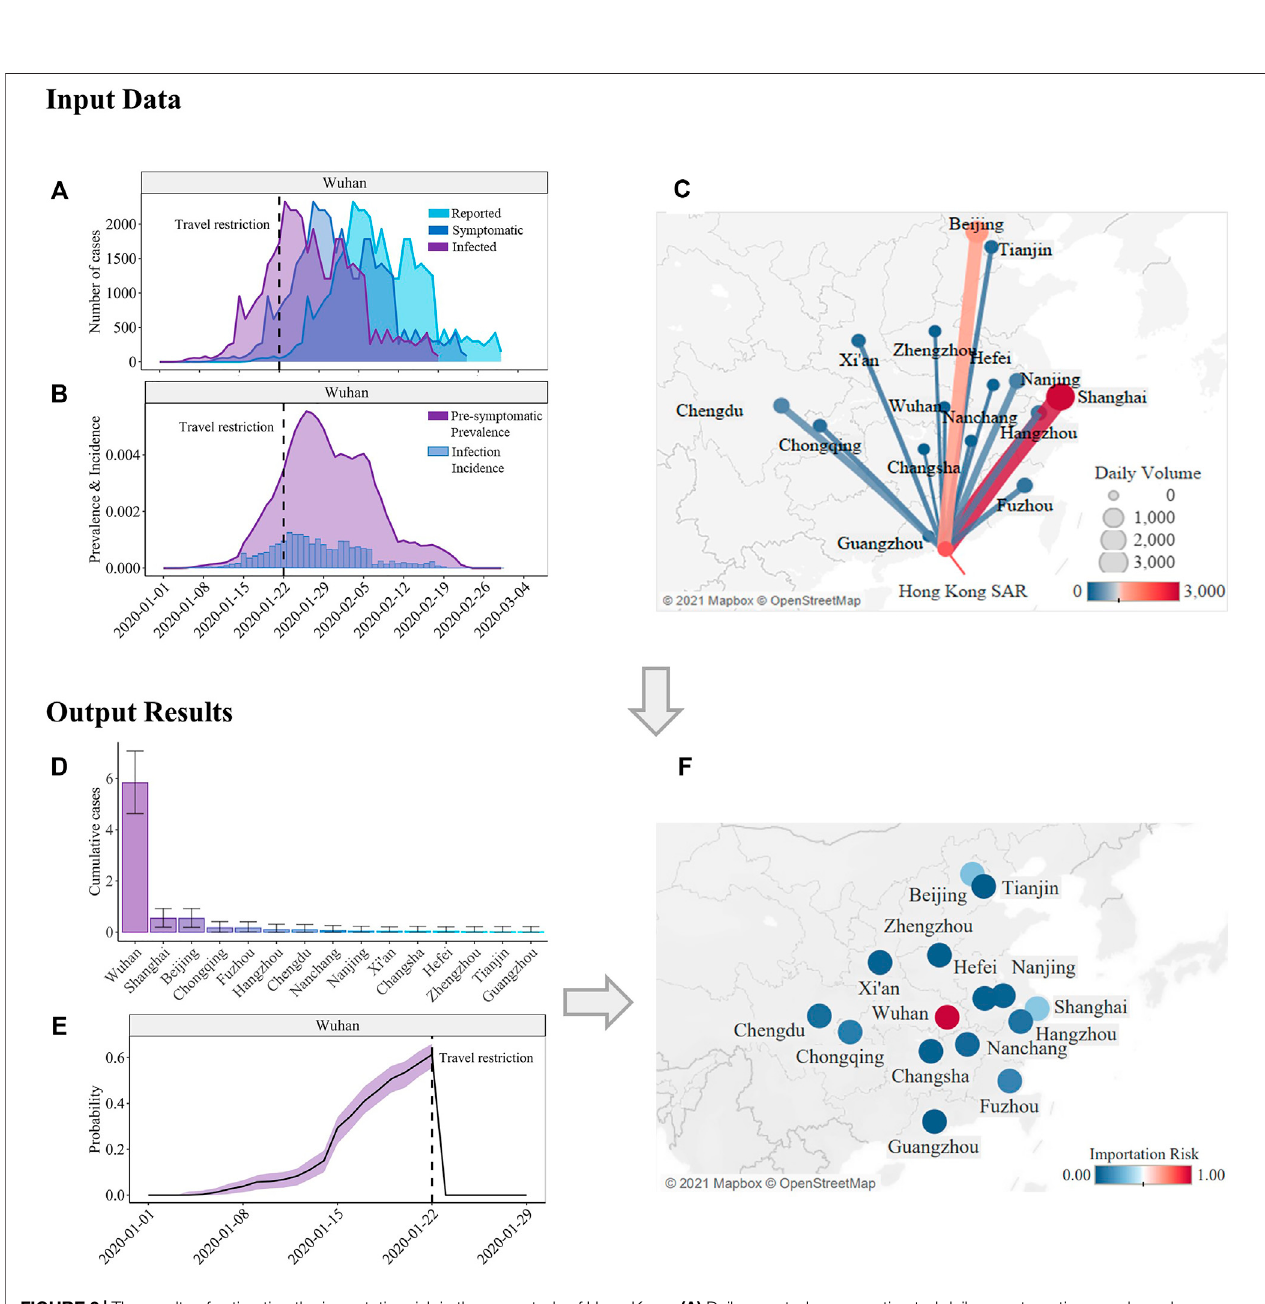
Tableau Software for Desktop version 2021.2.5 (https://www.tableau.com/support/releases/desktop/2021.2.5).